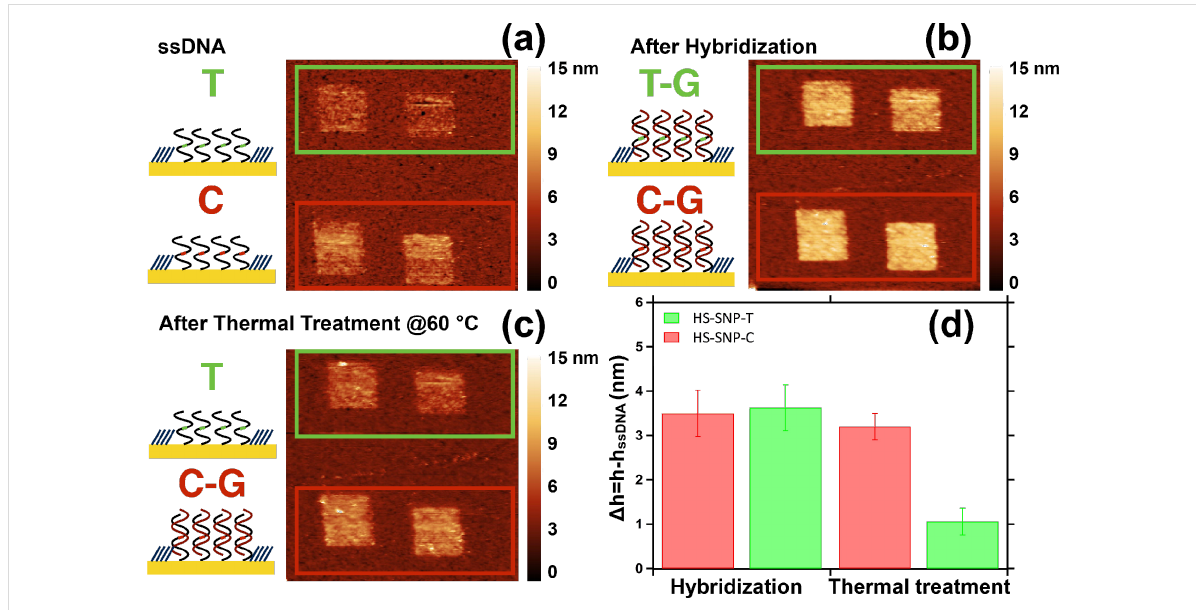
Figure 2: Schematic view and AFM topographic images of HS-SNP-C and HS-SNP-T nanografted patches (a) before and (b) after incubation with SNP-C for 1 h and (c) thermal treatment. (d) Histogram of the height variation with respect to the ssDNA patches ( Δ h = h − h ssDNA ) after the hybridi- zation with SNP-C-Co sequence and after the thermal treatment (1 h at 60 °C).